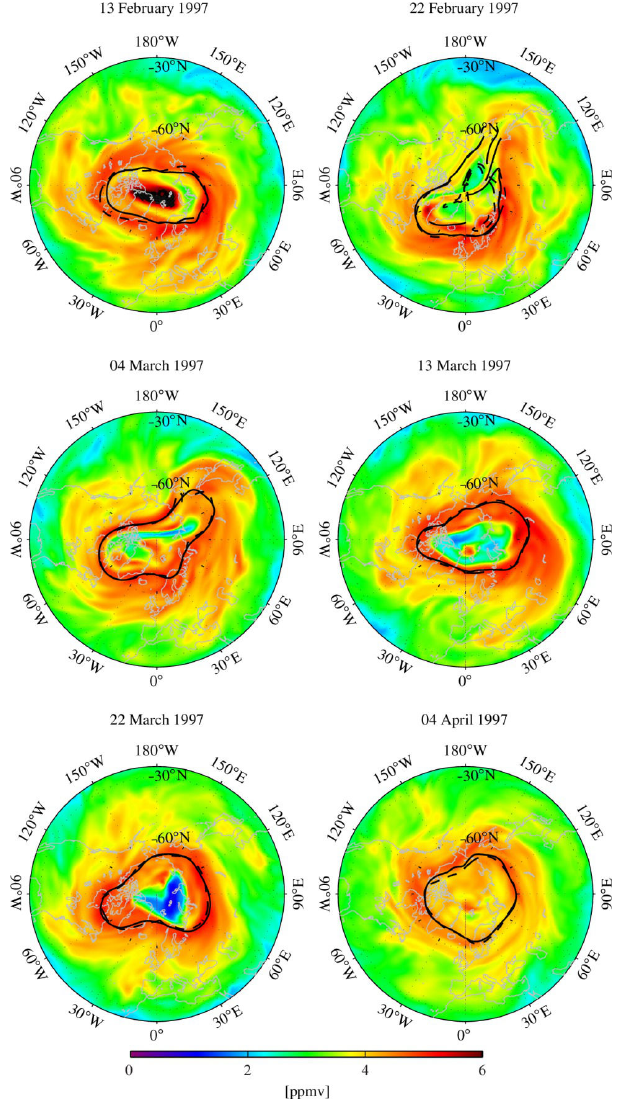
Fig. 4. Ozone concentration on the 475K isentropic surface on six different dates during the boreal winter/spring of 1997; super- imposed are the positions of forward- and backward-time FTLE trenches as in Figs.